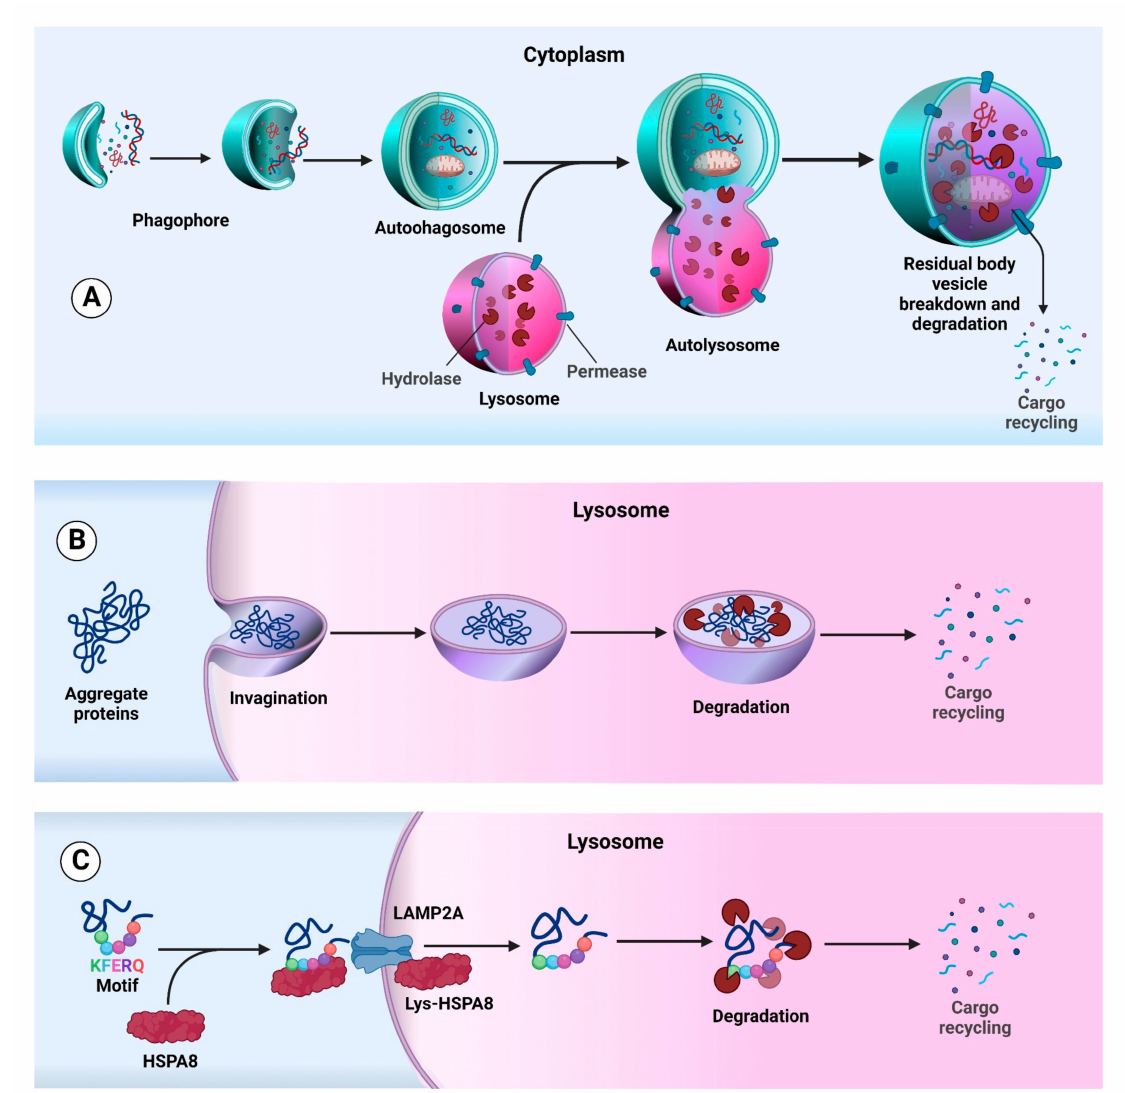
Figure 1. Schematic illustration of the main distinct autophagy mechanisms in mammals. ( A ) macroautophagy (autophagy), which includes initiation, phagophore expansion, autophago- some fusion with the lysosome, developing an autolysosome and cargo degradation steps; ( B ) microautophagy, in which the lysosome takes up small soluble particulates by invagination or protusion, followed by scission of the lysosomal membrane; and ( C ) CMA, which is a selective mechanism for proteins with specific amino acid motif (KFERQ sequence). The figure was created with BioRender.com. Licensing Right NX24OB5K3I, 21 November